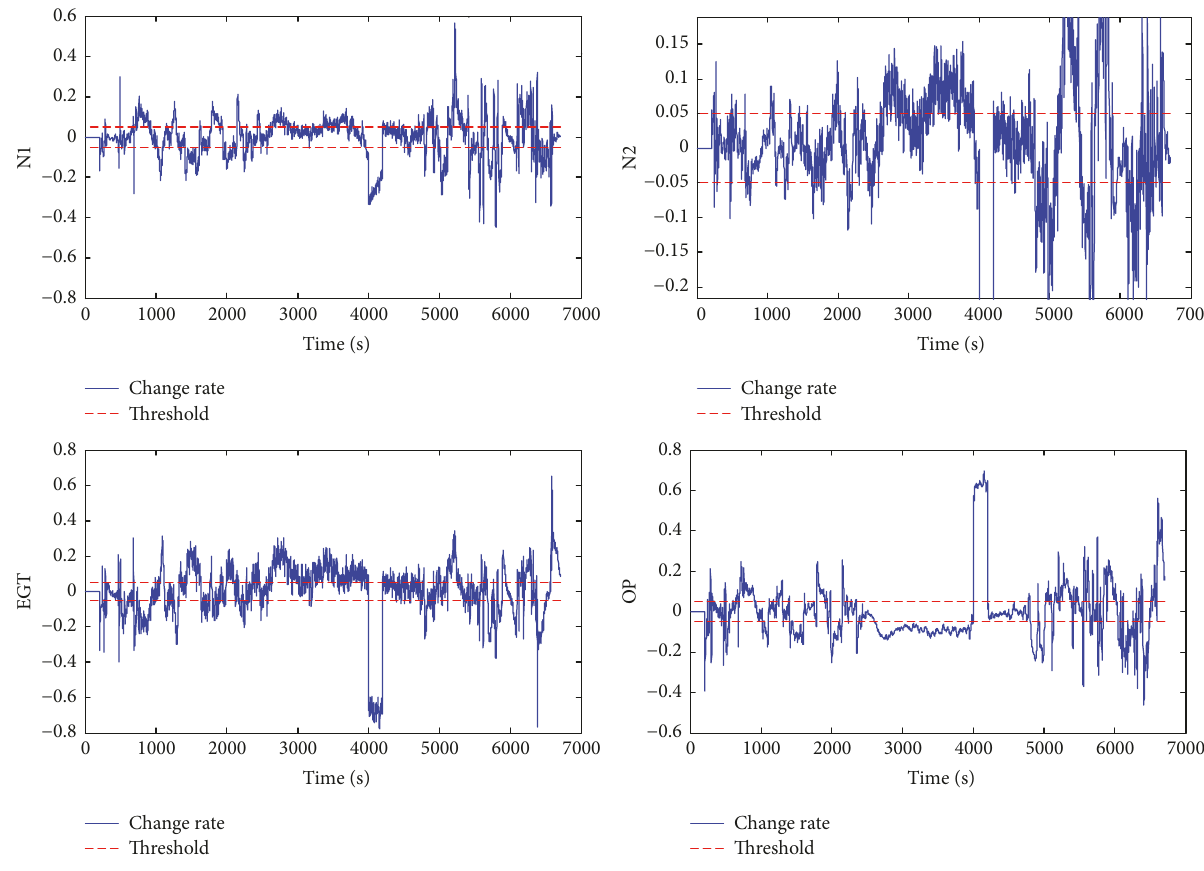
Figure 12: Change rate of spatial redundancy